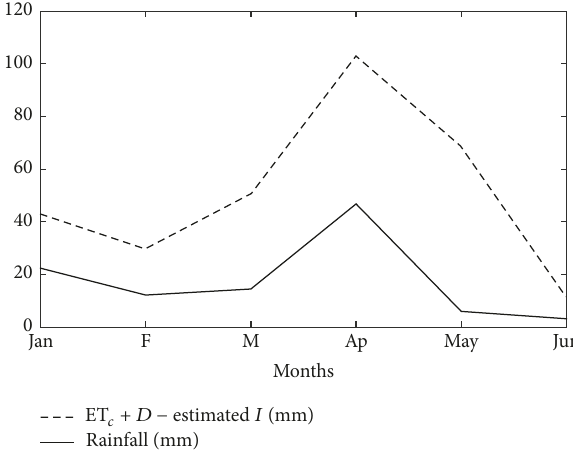
Figure 6: Relation between (ET 𝑐 + 𝐷 − estimated 𝐼 ) and